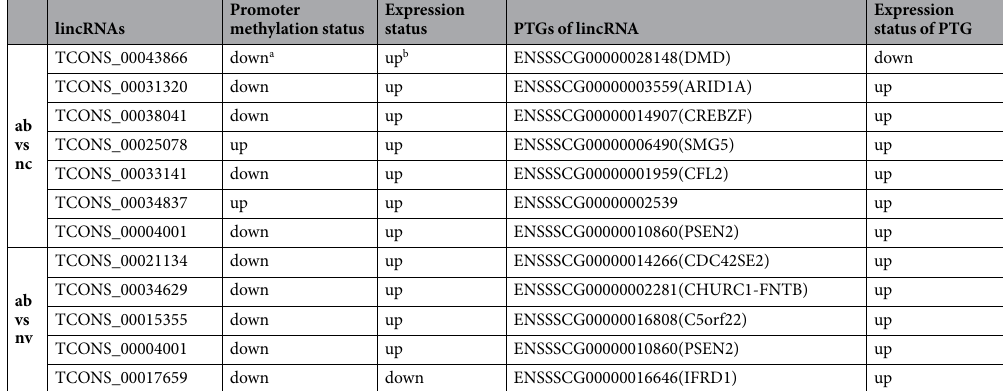
Table 2. Promoter methylation and expression status of lincRNAs and their PTGs expression in different comparisons. ab: the ab group; nc: the nc group; nv: the nv group. a Indicates this lincRNA had lower expression level in the ab group compared to another group. b Indicates this lincRNA had higher expression level in the ab group compared to another group.